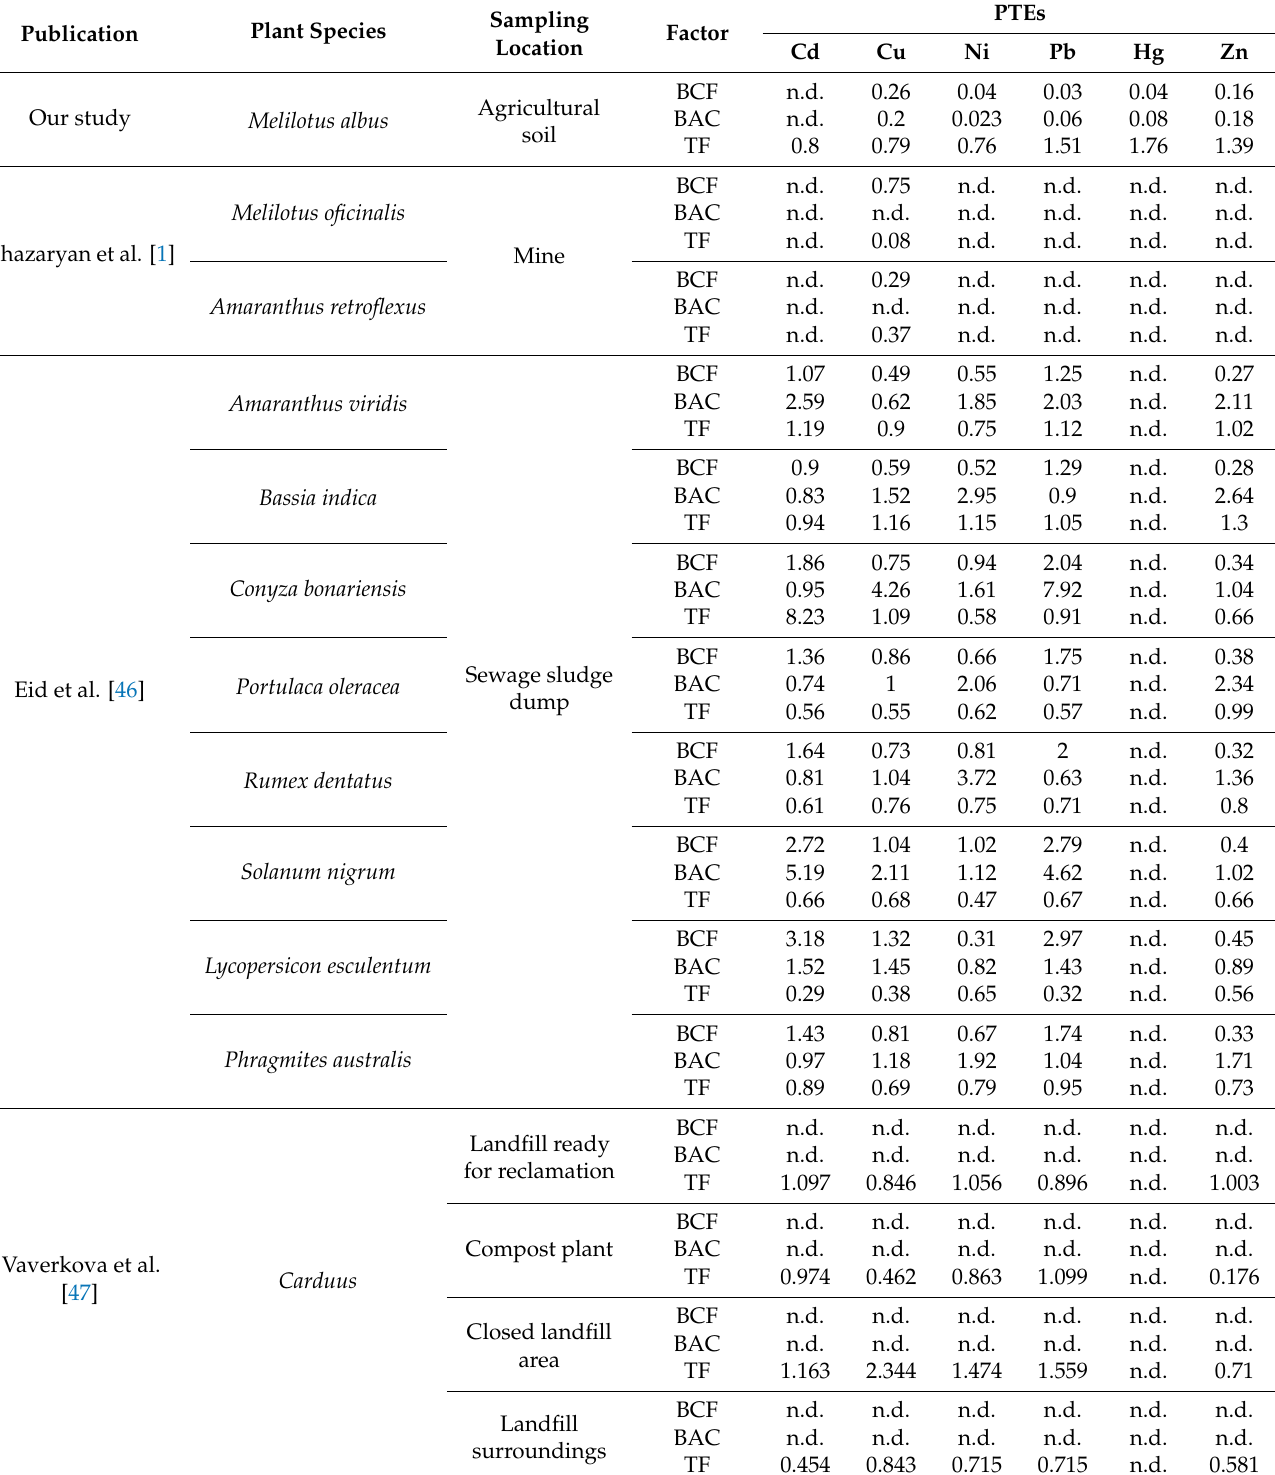
Table 4. The comparison of bioconcentration factor (BCF), bioaccumulation factor (BAC), and translocation factor (TF), in various studies and our